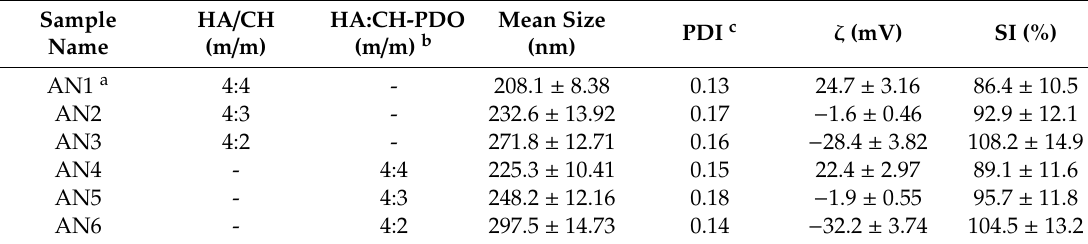
Figure 1. Transmission electron microscope (TEM) images of blank HA / CH NPs (hyaluronic acid / chitosan nanoparticles) ( A ) and blank HA / CH-PDO NPs (hyaluronic acid / chitosan-poly(dioxanone) nanoparticles) ( B ) as well as their size distribution ( C ). Table 1. Parameters of blank nanoparticles.